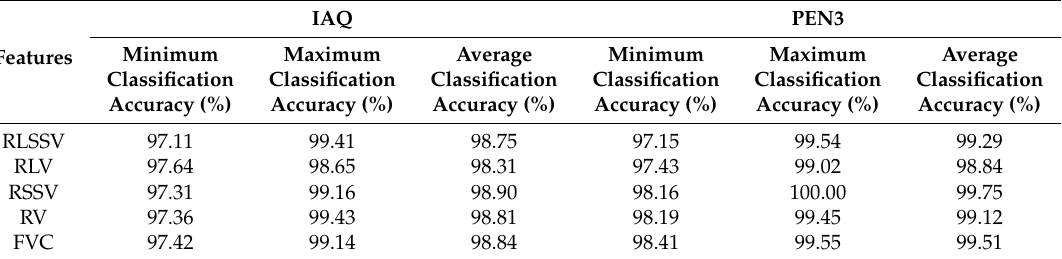
Table 5. Average PNN classification accuracies of features for IAQ and PEN3 datasets.